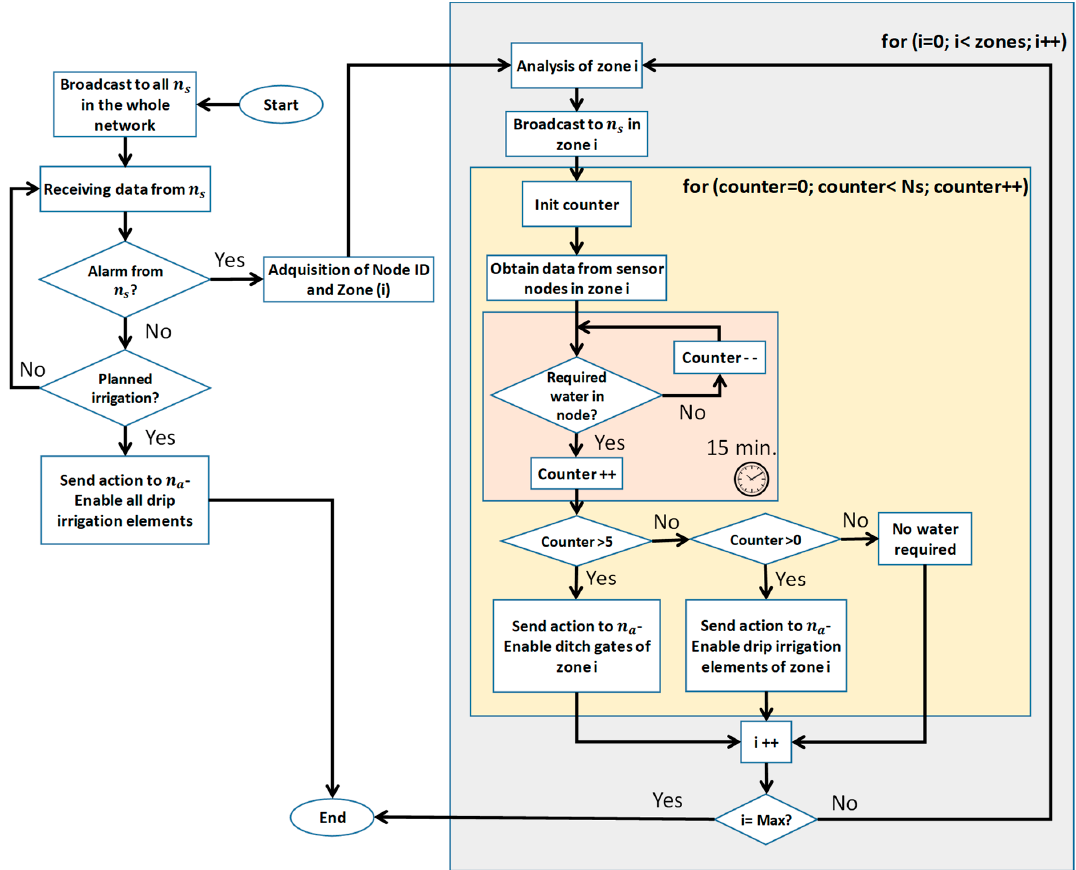
Figure 11. Operation algorithm.